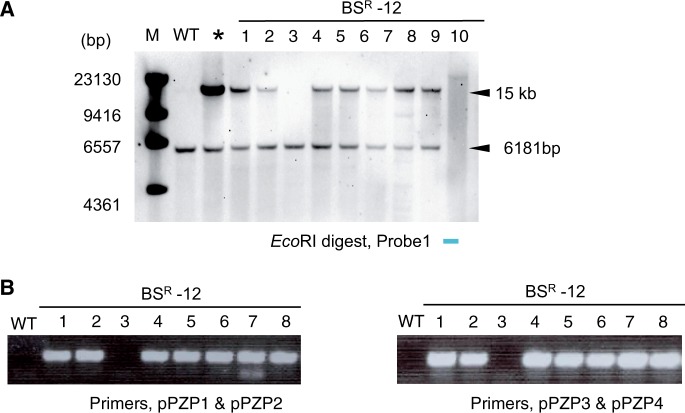
Detection of vector backbone sequence in siblings of BSR-12. (A) Southern blot analysis of T2 progeny of BSR-12 named BSR-12-1 to BSR-12-8. *GT vector was added to the WT. The position of the probe is shown in Fig. 1A. (B) PCR analysis using primers located near the LB and RB (Fig. 1A). Amplification of PCR products in BSR-12-1, 2 and 4–8 means that not only the T-DNA region but also the vector backbone sequence is integrated in these plants. The positions of the primers are shown in Fig. 1A.